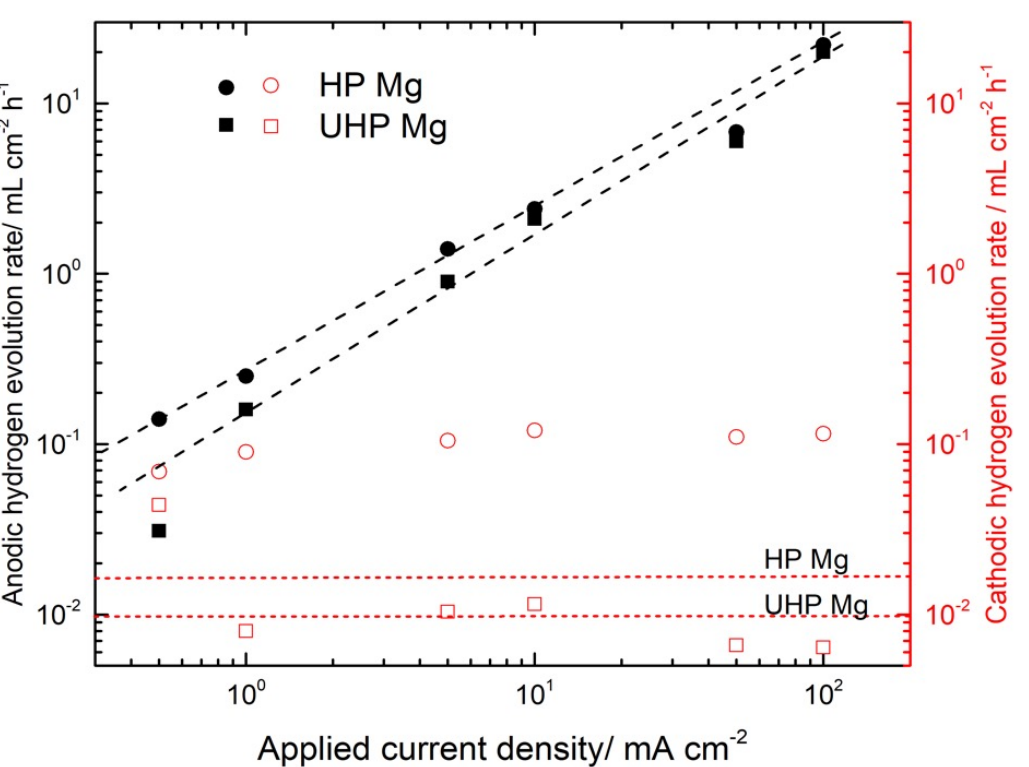
Figure 15. Anodic hydrogen evolution rate (closed symbols), and corresponding cathodic hydrogen evolution rate (open symbols) plotted against the applied anodic current density, replotted from the work of Fajardo and Frankel [95]. The enhanced catalytic evolution mechanism predicts that the “enhanced” cathodic hydrogen evolution rate must be equal to the anodic hydrogen evolution rate. The fact that the “enhanced” cathodic hydrogen evolution rate was significantly less than the anodic hydrogen evolution rate for substantial applied anodic current densities in Figure 15 indicates that experimental evidence contradicted the enhanced catalytic activity mechanism of Mg corrosion.